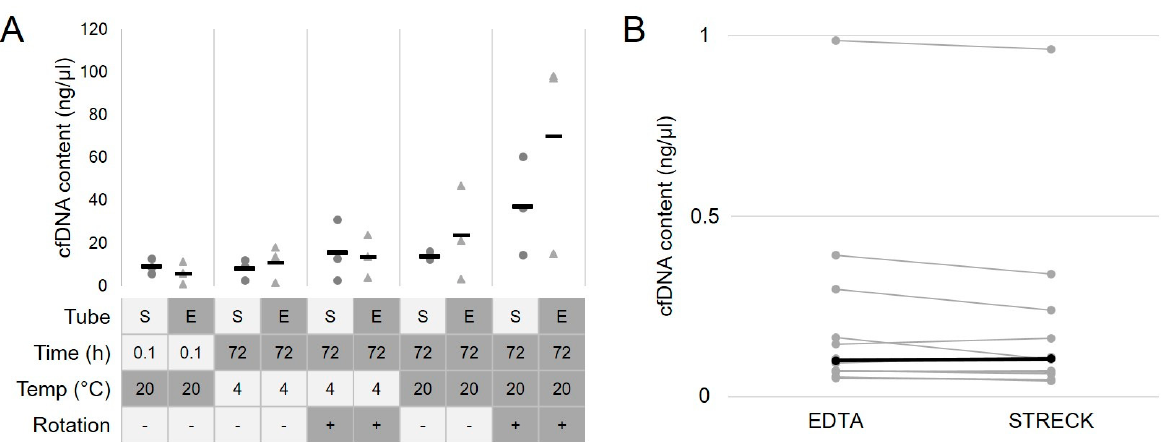
Figure 1. Impact of storage time, storage temperature and physical stress due to prolonged transport of samples on cfDNA concentrations. ( A ) cfDNA concentrations rise over time and physical stress.